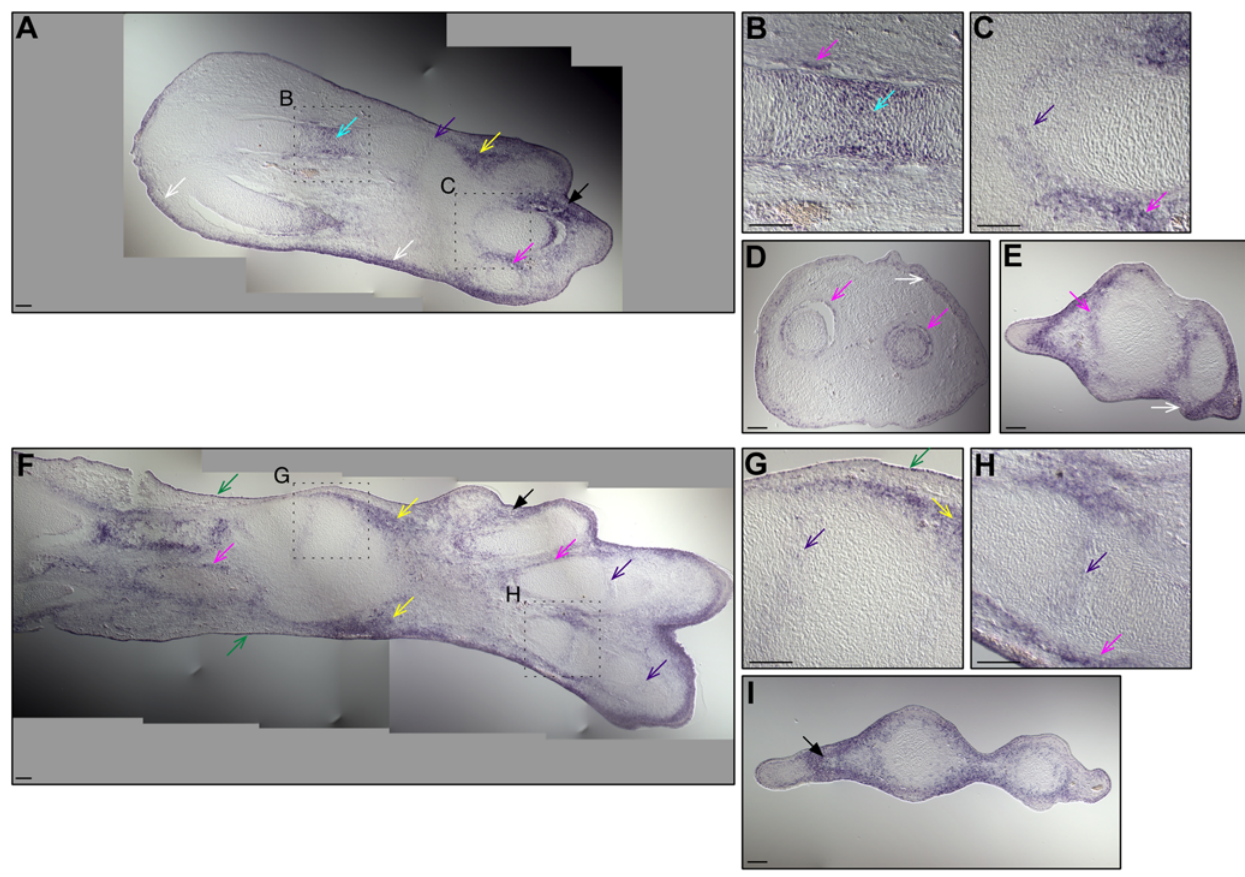
Figure 3. cSmad6 is expressed in limb mesenchyme, epidermis and cartilage. Expression of cSmad6 mRNA in longitudinal (A–C, F–H) and transverse (D, F, I) sections of HH st29 forelimbs (A–E) and hindlimbs (F–I). B, C, G, H are higher power images of labeled areas in A and F. Arrows indicate expression of cSmad6 in interdigital mesenchyme (black arrow); hypertrophic chondrocytes (blue arrow); perichondrium/mesenchyme adjacent to cartilage (magenta arrow); nascent joints (purple arrow); interstitial mesenchyme (yellow arrow); subepidermal mesenchyme (white arrow); epidermis (green arrow). Scale bars indicate 100 m m.